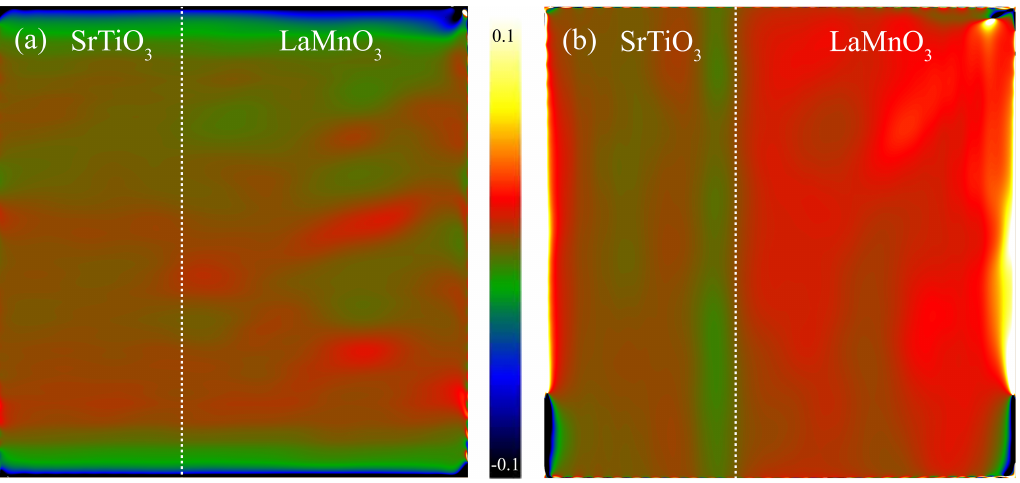
Figure 6. Geometrical phase analysis of LaMnO 3 film showing in-plane ( a ) and out-of-plane ( b ) strain states.